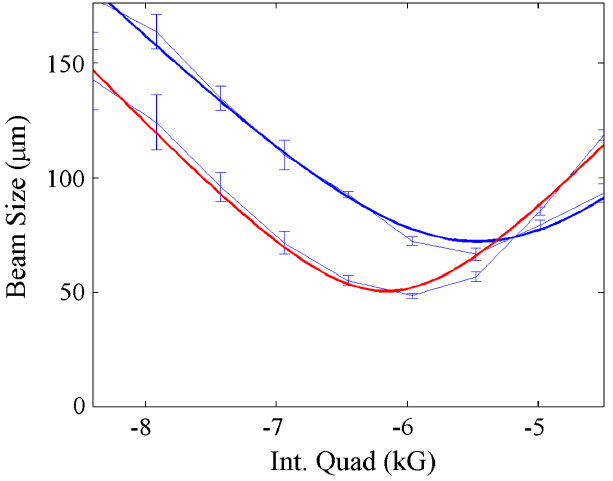
FIG. 27. Quadrupole scans with 30 pC bunch charge: (blue) horizontal plane and (red) vertical plane. The fits give a normalized horizontal emittance of 0.47 mm-mrad and a nor- malized vertical emittance of 0.43 mm-mrad.